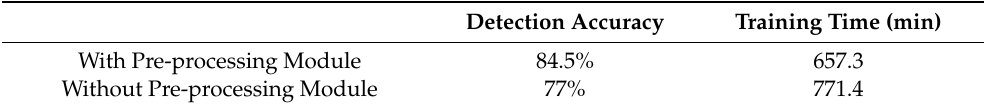
Table 3. The comparison results obtained by the models trained with and without the image pre- processing